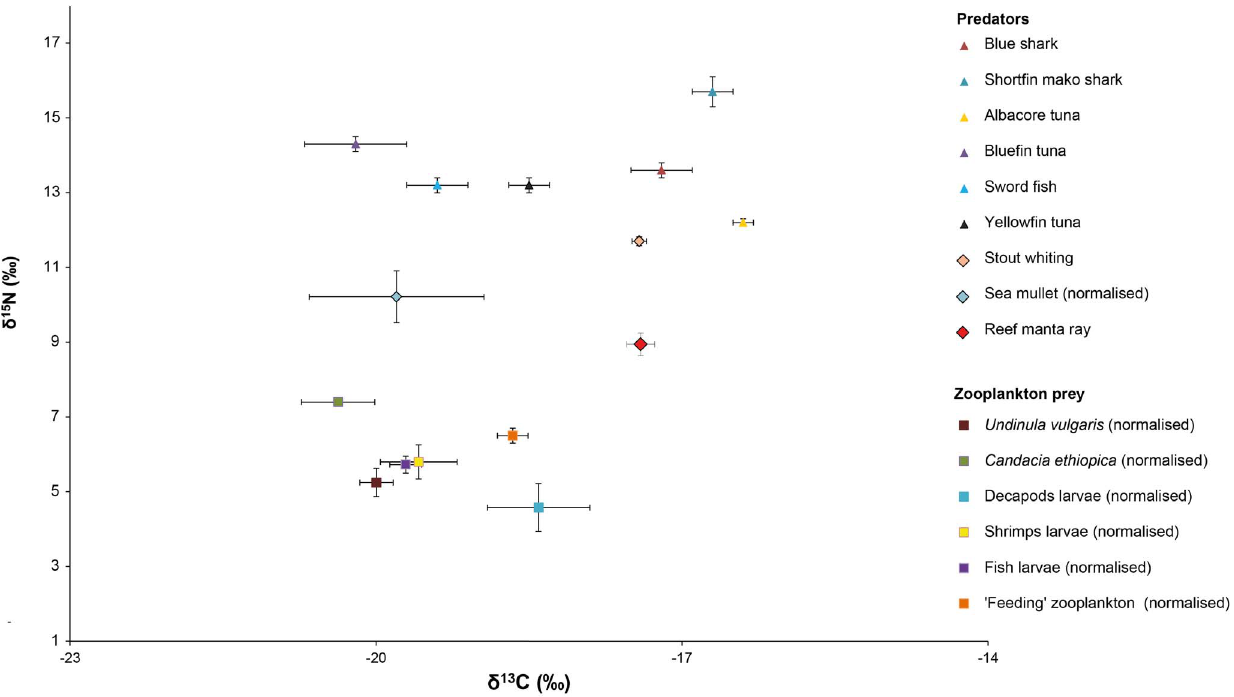
Figure 1. d 15 N and d 13 C values of zooplankton, pelagic predators and reef manta rays from southeast Queensland waters. Different symbols and colours indicate the mean isotopic values of different groups and species. All zooplankton values are adjusted to account for lipid normalisation based on Post [53]. Pelagic predator values (indicated by triangle icons) are based from Revill et al. [50]. Error bars represent standard error.